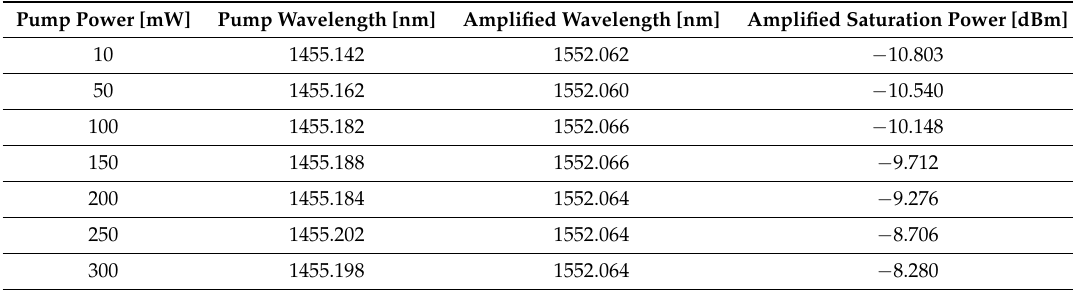
Table 1. Pump power vs. saturation power of a Raman